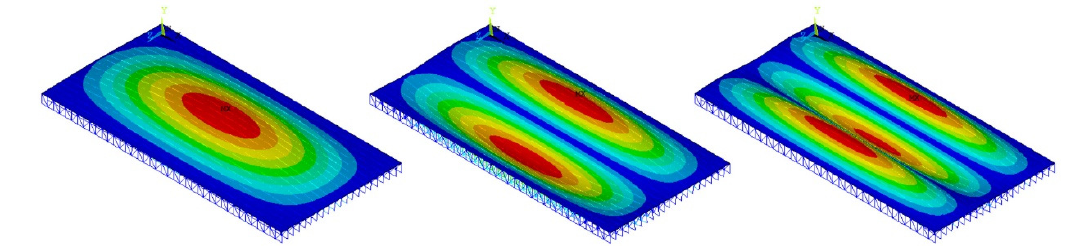
Figure 23. The first three modes of the numerical model of the floor.